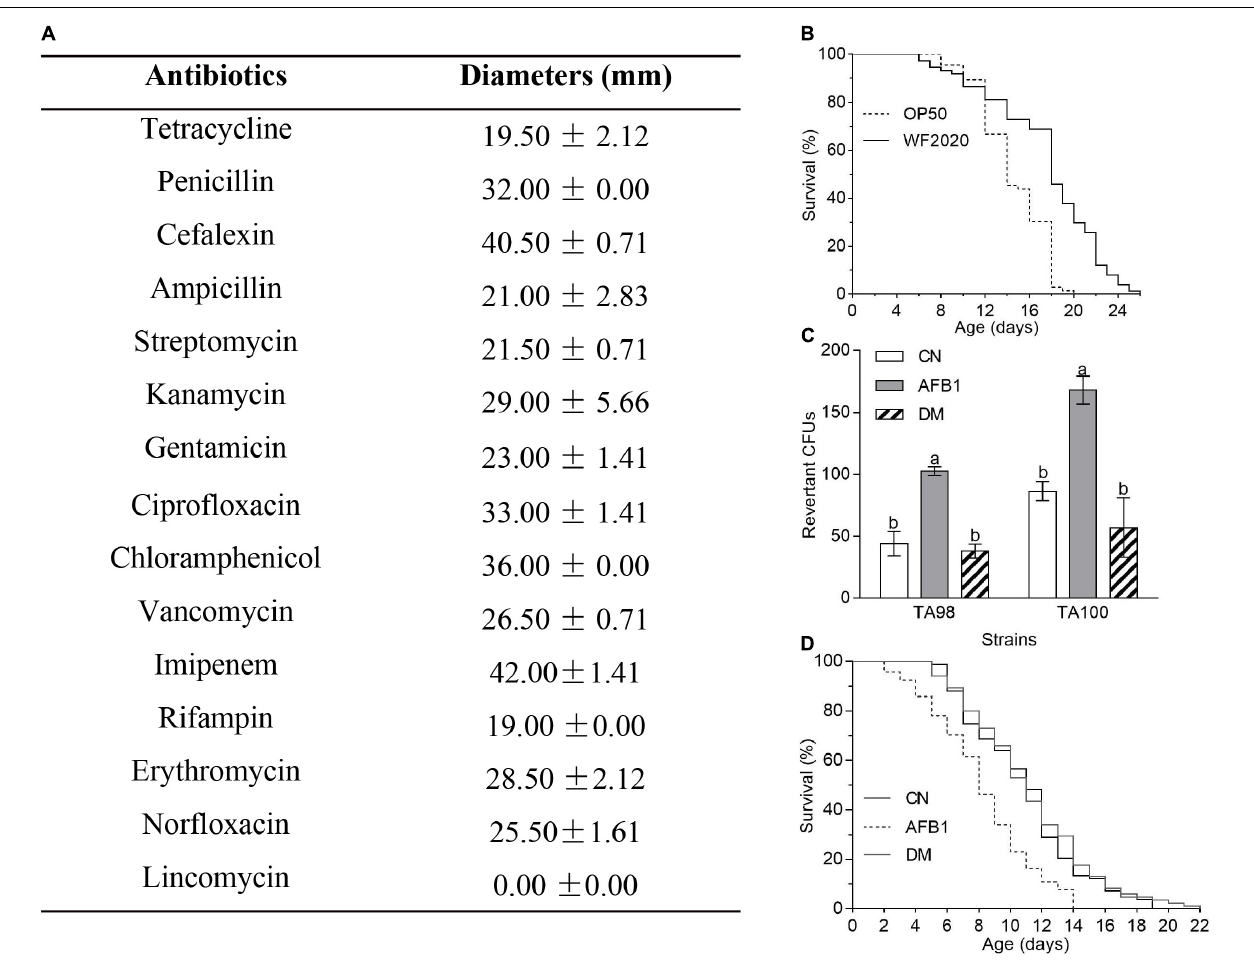
FIGURE 3 | The safety of B. amyloliquefaciens WF2020 and its AFB1 degradation products. (A) Susceptibility of B. amyloliquefaciens WF2020 to different antibiotics by the disk diffusion test. (B) Changes in the lifespan of C. elegans N2 caused by B. amyloliquefaciens WF2020. (C,D) Reduction of AFB1 mutagenic effects (C) and the toxicity to C. elegans N2 (D) caused by B. amyloliquefaciens WF2020. The AFB1 group means extracts from the media supplemented with 20 µ g AFB1. The DM group refers to the culture extracts from the supernatant of the 96 h co-incubation of 20 µ g AFB1 and B. amyloliquefaciens WF2020. The CN group means the control group. Different lowercase letters in the bars of each group indicate significant differences between treatments (Tukey’s test, p <